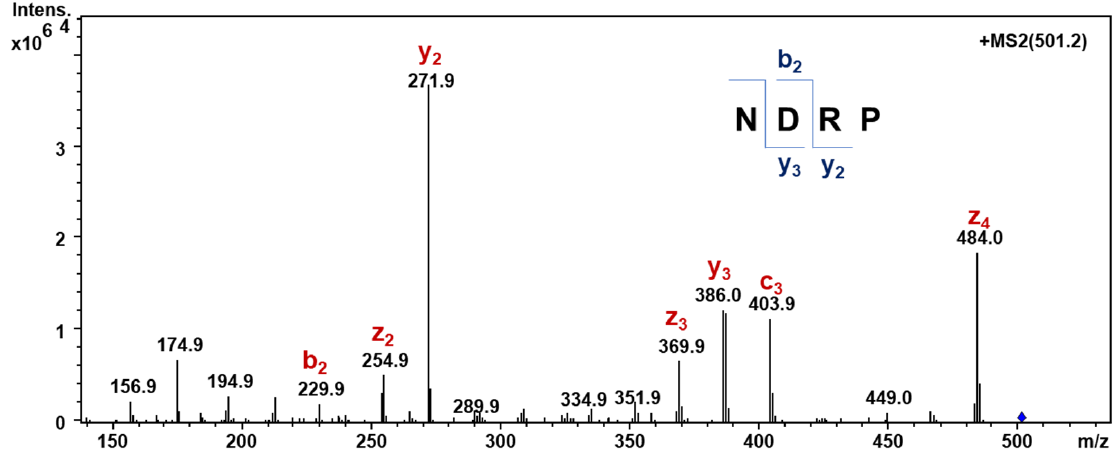
Figure 4. MS/MS spectrum of NDRP detected by infusion of A < 1 kDa by MRM.